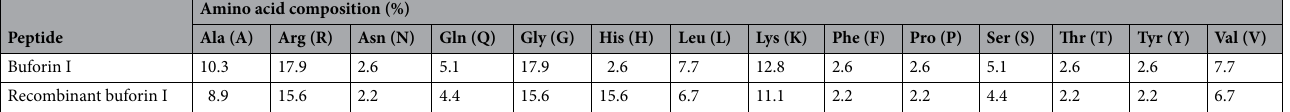
Table 3. Amino acid composition of buforin I and recombinant buforin I by Protparam.